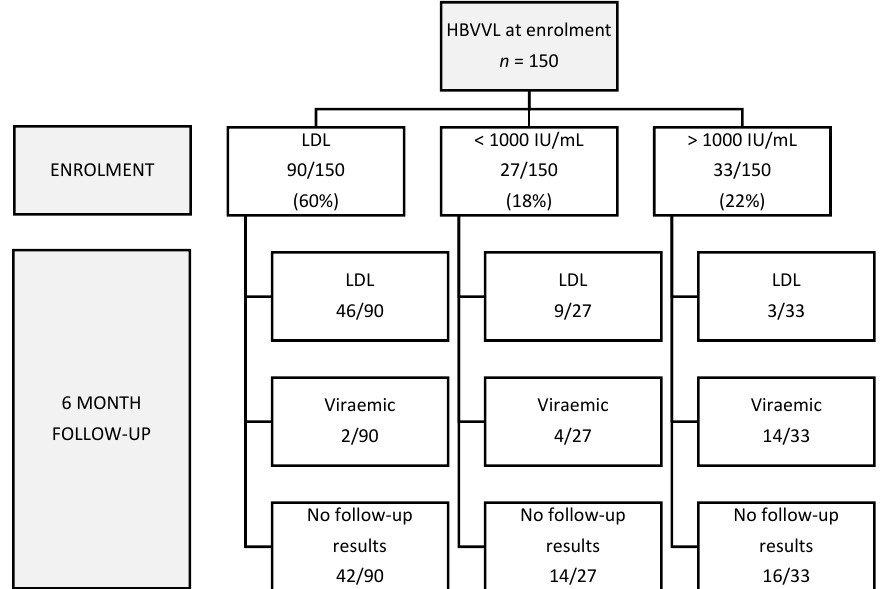
Figure 1. Flow chart: HBVVL at baseline and follow-up. Table 2. Factors associated with HBV viraemia at follow up.